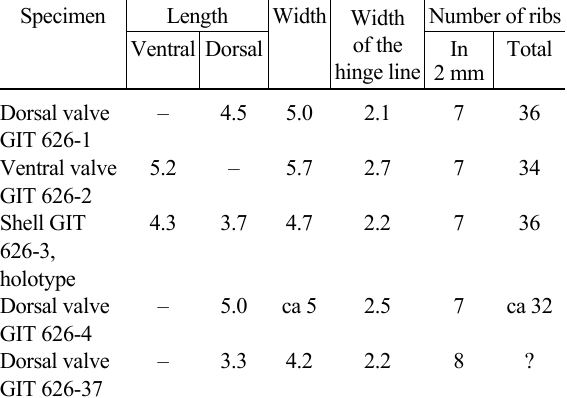
Table 2. Measurements (in mm) of Mendacella aerinensis sp. nov.